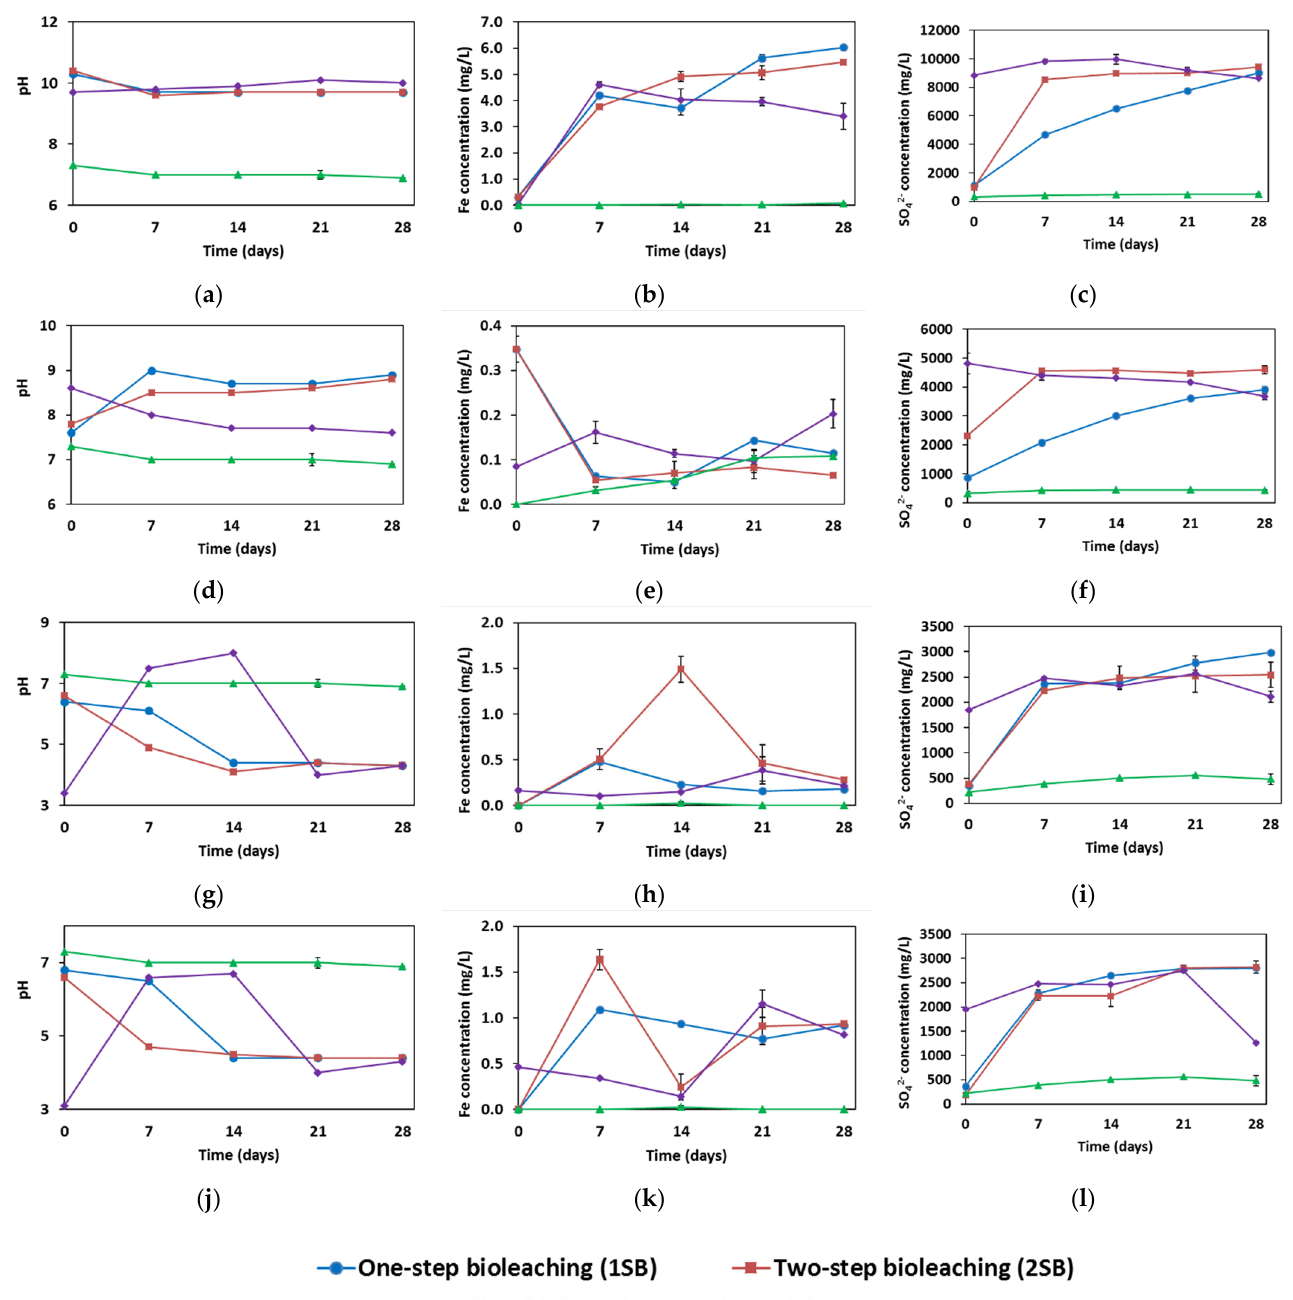
Figure 1. The evolution of pH, Fe and sulphate (SO 42 − ) concentrations during the bioleaching of the Neves Corvo waste rock (NC_01) by T. cyclica ( a – c ) , T. thiocyanaticus ( d – f ) , T. electrotropha ( g – i ) and T. pacifica ( j – l ) . Values are the average of duplicate flasks ± standard deviations. Sulphur oxidation by T. cyclica produced sulphuric acid, thereby drastically increasing the SO 42 − concentration and reducing the solution pH within the first 7 days. Specifi- cally, there was a steep increase in sulphate concentration from its initial concentration (~1000 mg/L) on day 0 to 5000 mg/L (for 1SB) and 8535 mg/L (for 2SB) on day 7. The SO 42 − concentration continued to increase, reaching 9000 mg/L by the end of the 1SB and 2SB experiments. The pH decreased from 10.3 to 9.7 within the first 7 days during the exponential growth phase of T. cyclica and remained relatively constant until the end